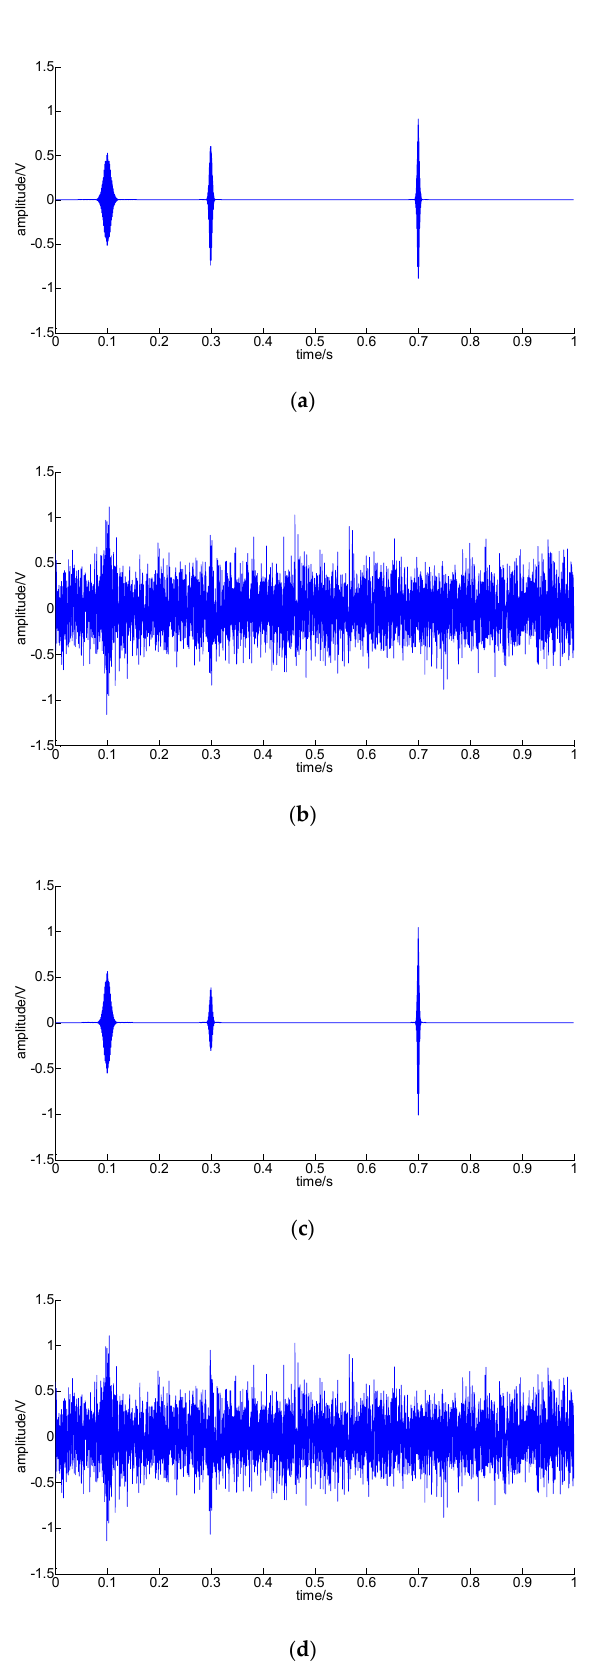
Figure 8. The decomposed results: ( a ) sparse representation, proposed method; ( b ) residual, proposed method; ( c ) sparse representation, traditional method; ( d ) residual, traditional method. Figure 7a,c,e shows that the optimal spectra with the proposed method can greatly suppress noise by preprocessing through the filtered TEO, and the corresponding are close to 3 times those of the simulated impulses. Figure 7b,d,f shows that the optimal